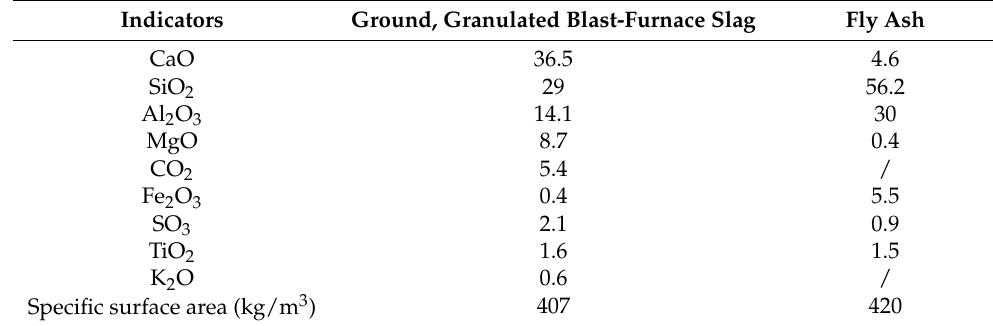
Table 1. The technical indicators of FA and GGBS.